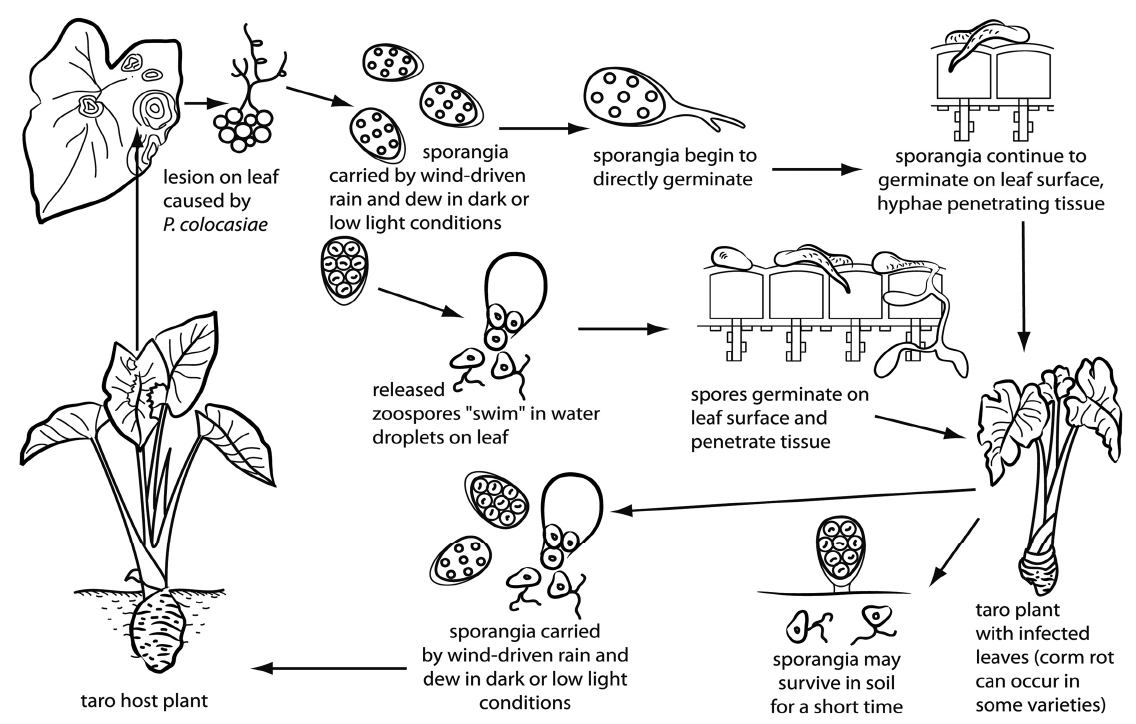
Figure 1. Sporangia of P. colocasiae germinating directly and also by production of